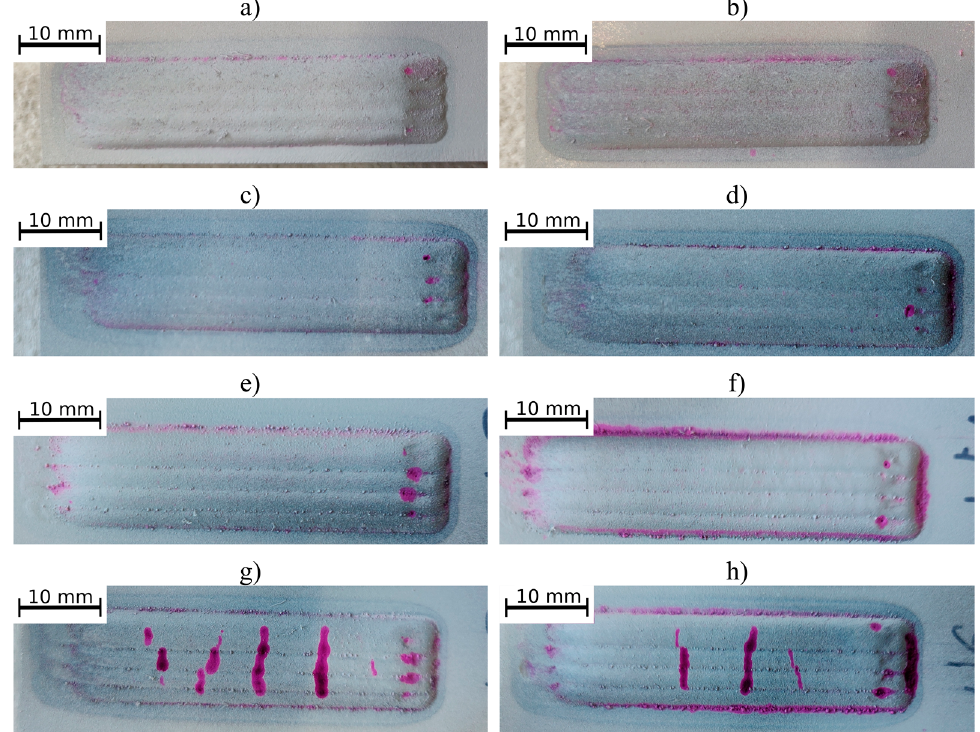
Figure 2. Surface of the coatings after penetrant testing: ( a ) M1, ( b ) M2, ( c ) C1, ( d ) C2, ( e ) C3, ( f ) C4, ( g ) C5 and ( h ) C6, designations in accordance with Table 3.